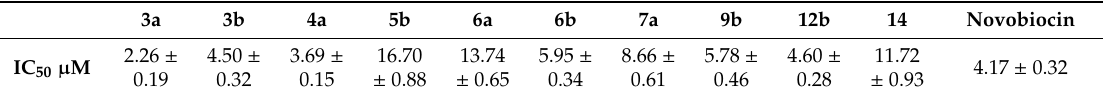
Table 3. E. coli DNA gyrase supercoiling inhibition (IC 50 µ M) of compounds 3a,b, 4a, 5b, 6a,b, 7a, 9b, 12b, and 14 and reference antibiotic (novobiocin).